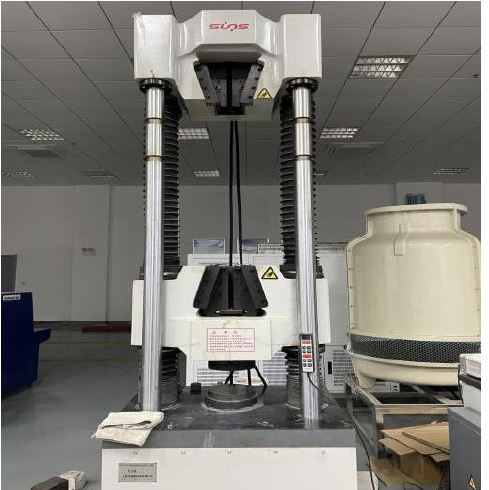
Figure 3. WDW-1000 computer-controlled electronic universal testing machine.